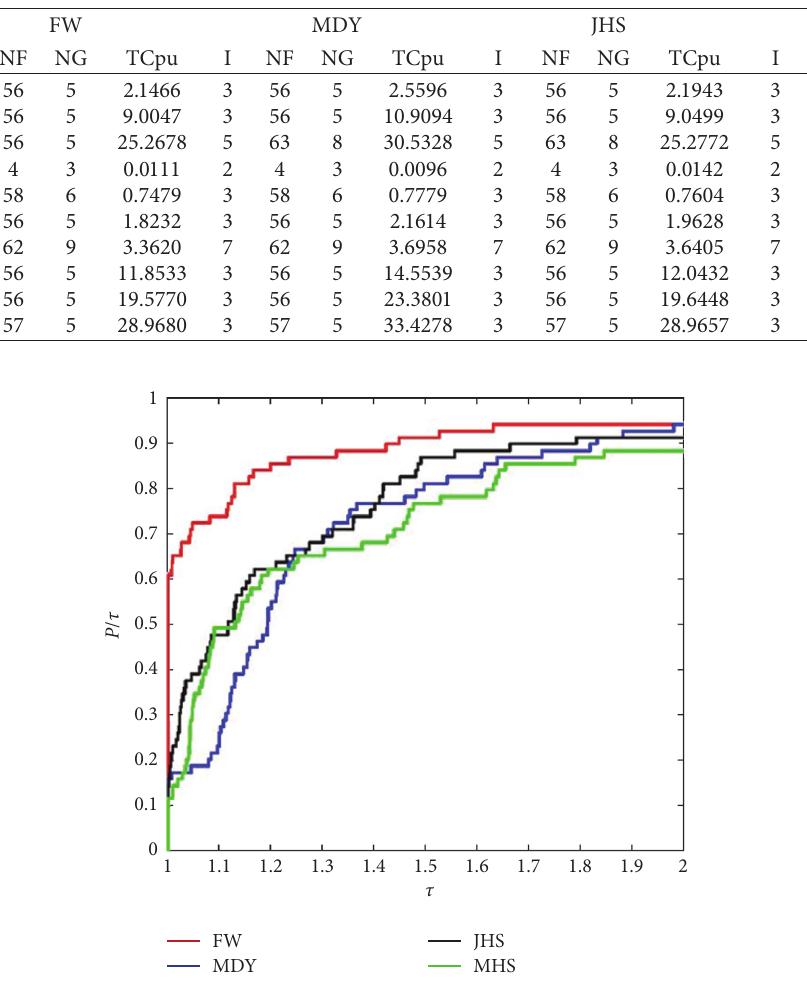
Figure 1: Performance profiles with respect to CPU time (FW versus MDY, JHS, and algorithm. To test and compare the computation effect of the proposed FW, a large number of testing problems from Mor`e et al. [21] are solved by the FW, MHS [16], MDY [18], and JHS [19]. In all conjugate gradient methods, the step length α k is yielded by the Wolfe line search (4). All codes were written in Matlab 7.5 and run on Dell with 2.90 GHz CPU processor, 8 GB RAM memory, and Windows 10